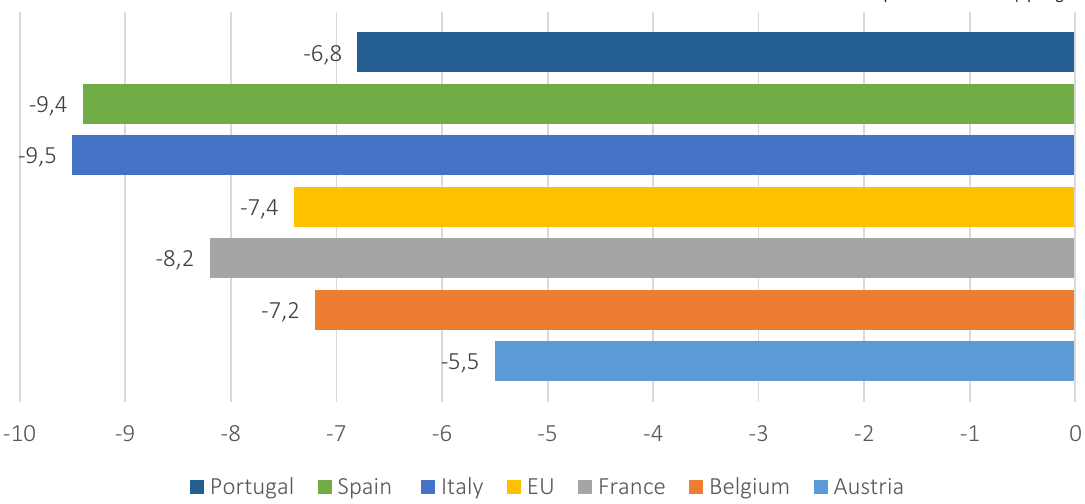
Figure 3. Change in GDP volume (percentage change compared to